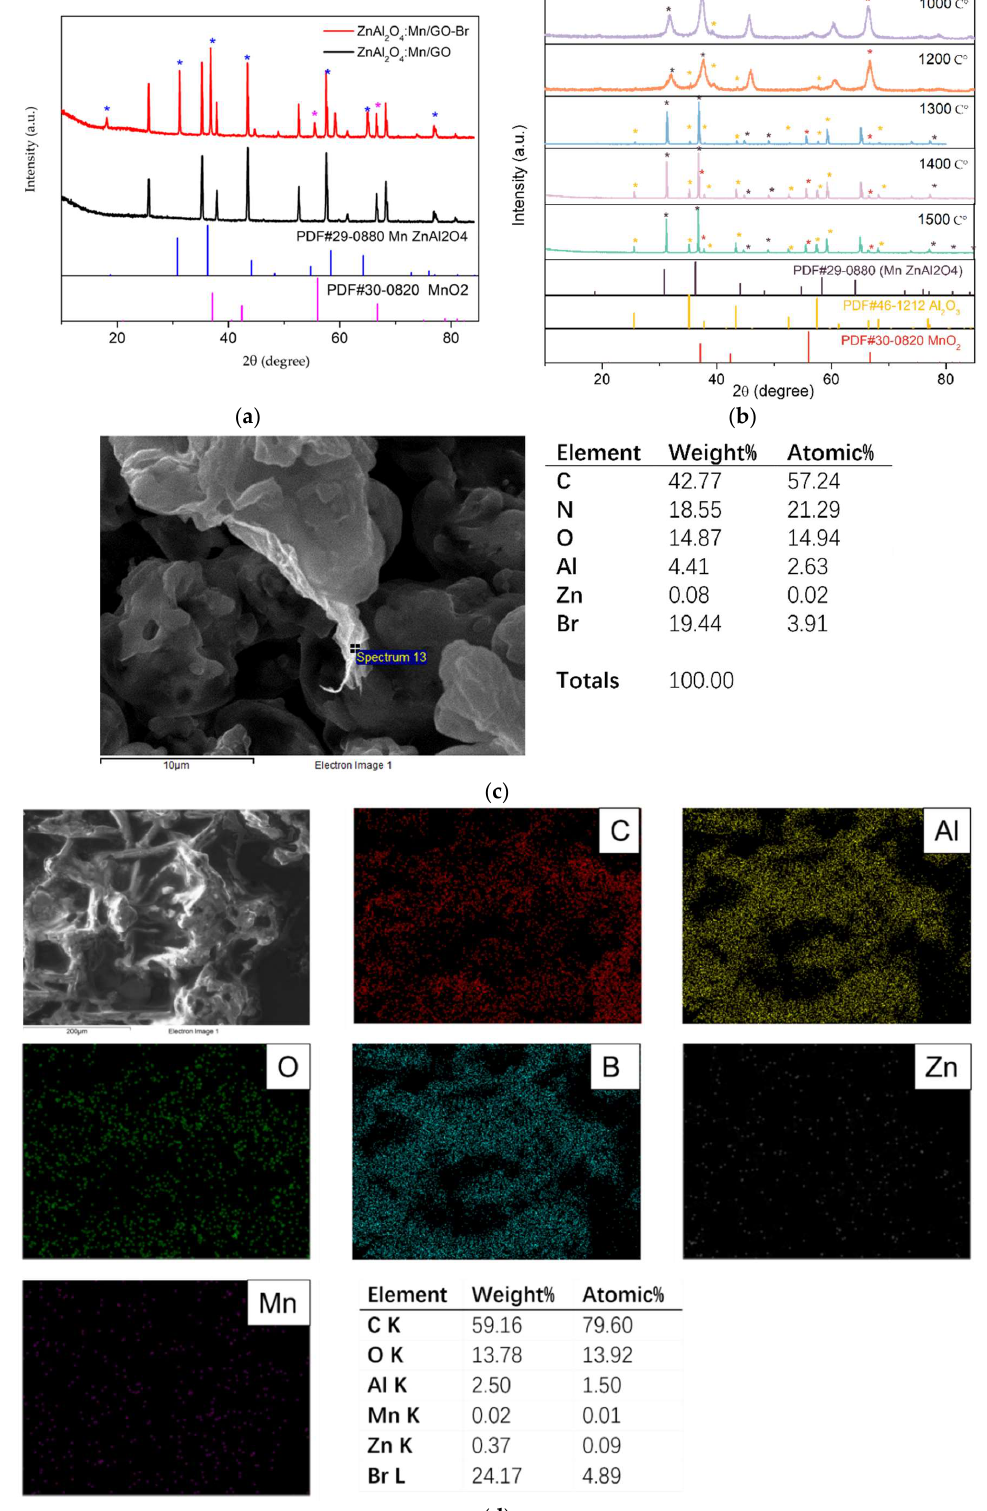
Figure 5. XRD of ( a ) ZnAl 2 O 4 : Mn/GO-Br and ZnAl 2 O 4 : Mn/GO; ( b ) ZnAl 2 O 4 : Mn annealed in air at different temperatures (1000 ◦ C, 1200 ◦ C, 1300 ◦ C, 1400 ◦ C and 1500 ◦ C); ( c ) EDS of wrinkled